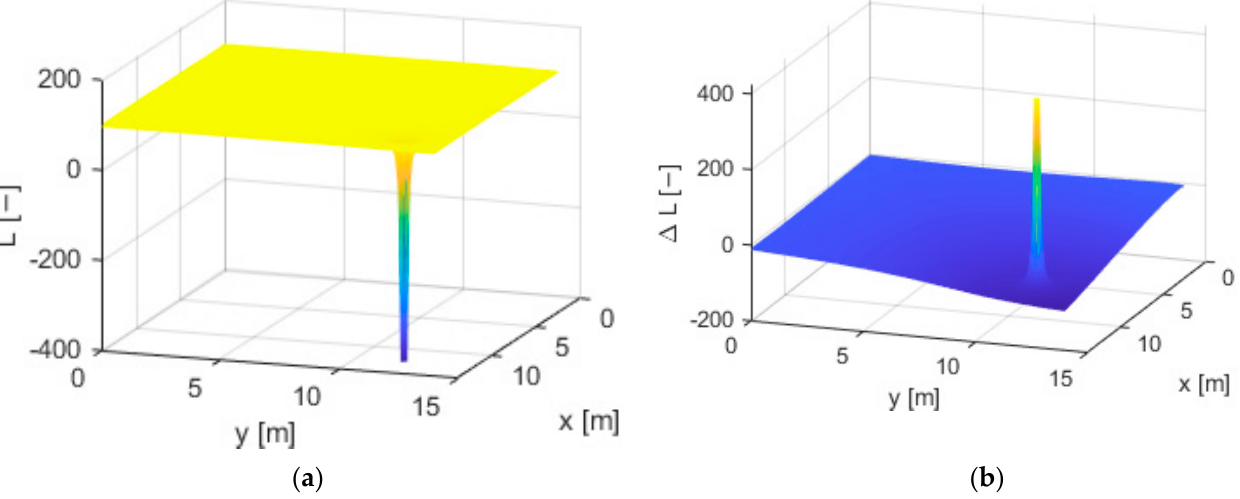
Figure 10. ( a ) Results of the Lyapunov function 𝐿 in the entire navigation area for Agent K; ( b ) Results of the Lyapunov incremental function ∆𝐿 over the entire navigation area for Agent K.